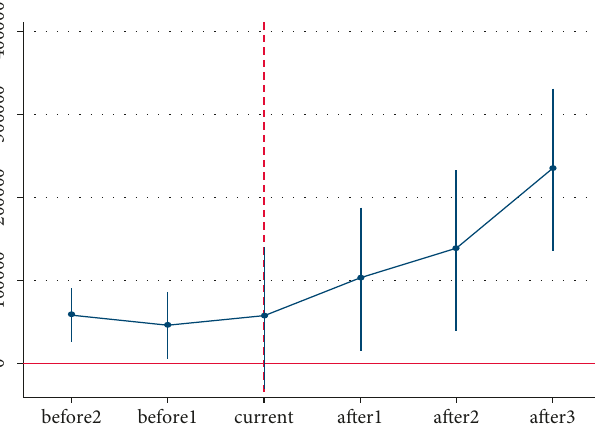
Figure 1: Parallel trends in domestic tourism